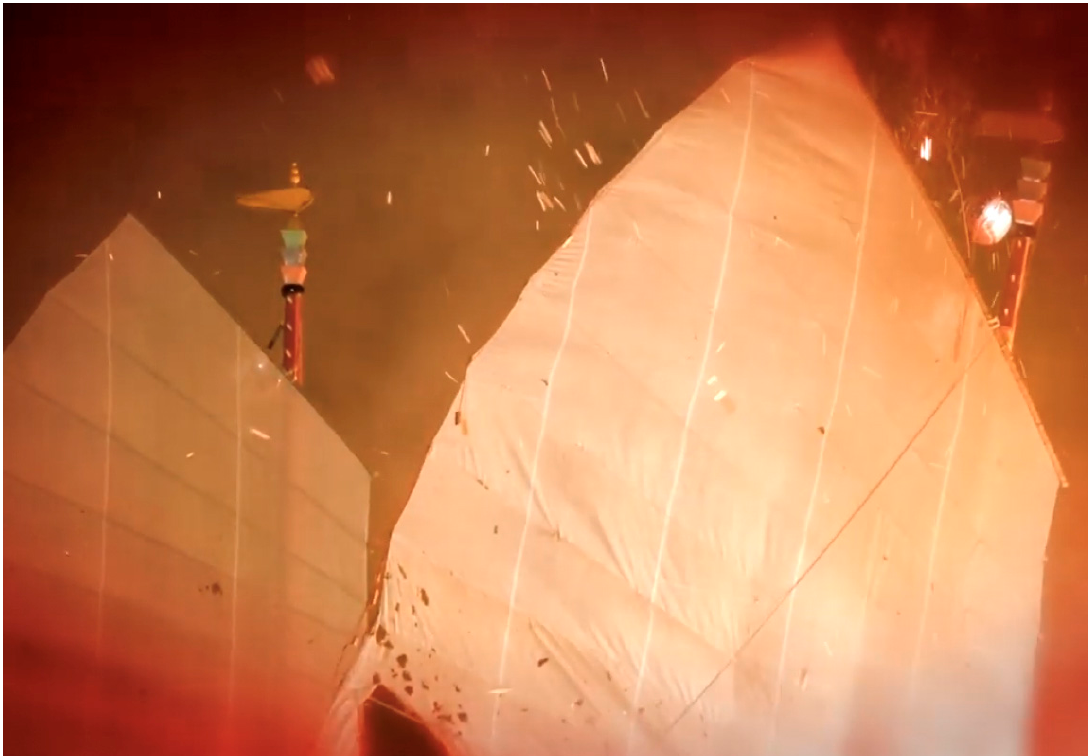
Figure 11. Incineration of the boat’s sails at the Wang Yeh boat burning festival. Image courtesy of Ye Mimi.